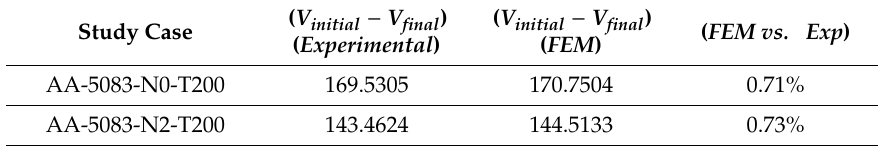
Table 3. Comparison of loss of volume (mm 3 ) during both the wear tests and FEM, after 200 × 10 3 rev. Study